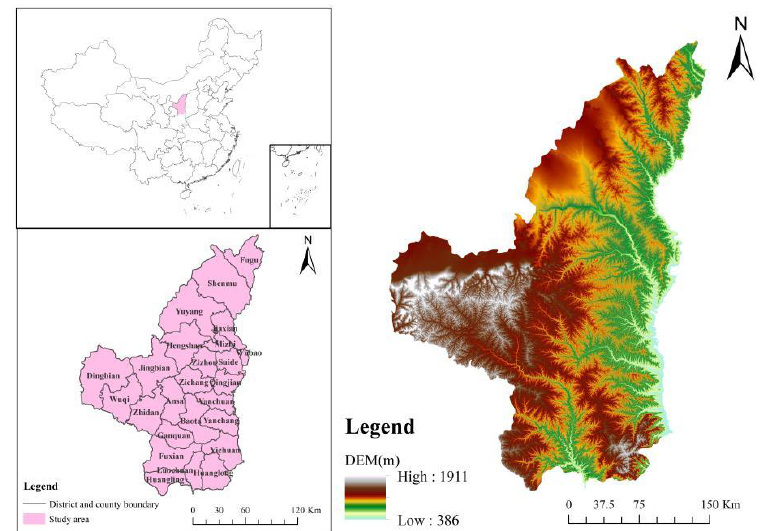
Figure 1. Location of the study area.